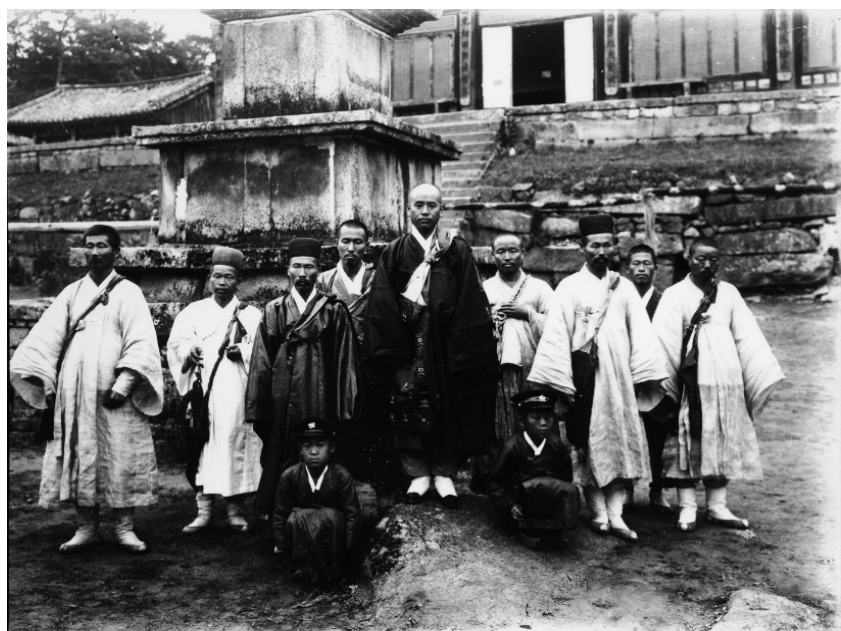
Figure 2. Yi Hoegwang (center) and leading monks of Haeinsa in 1910. Print from dry plate. Kŏnp’an 550. Courtesy of National Museum of Korea.